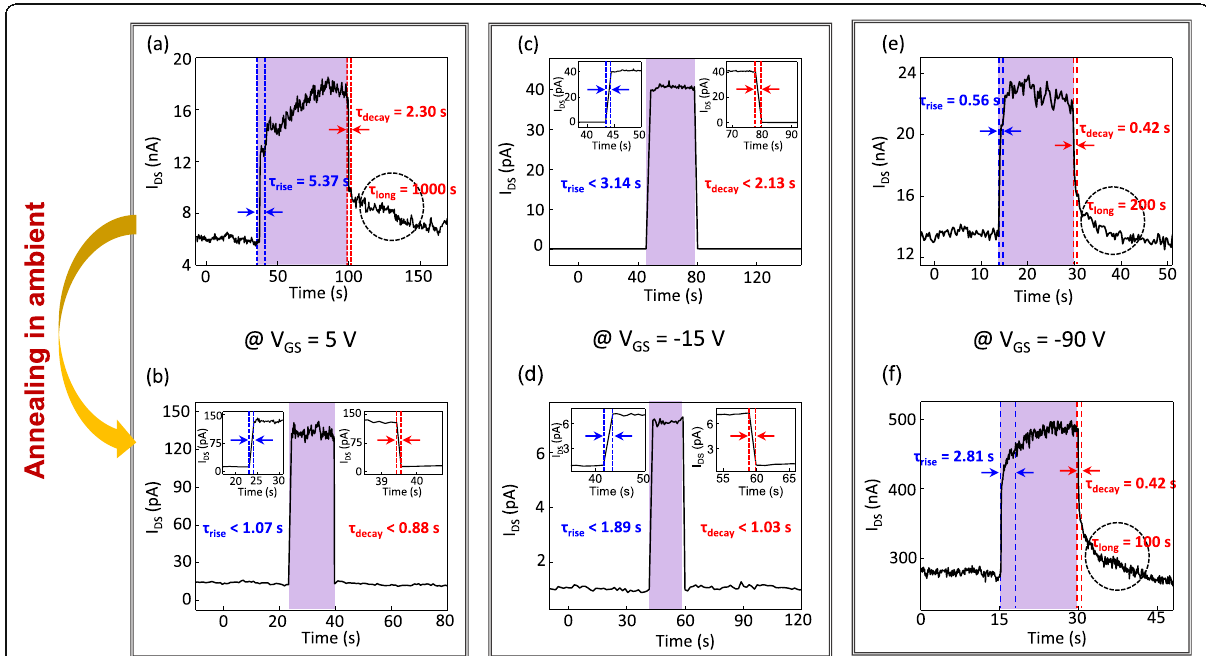
Fig. 4 a W and b Se peaks in XPS spectra of WSe 2 before and after annealing in ambient at 250 °C for 1 h and 5 h. c Schematics of the structural changes in the